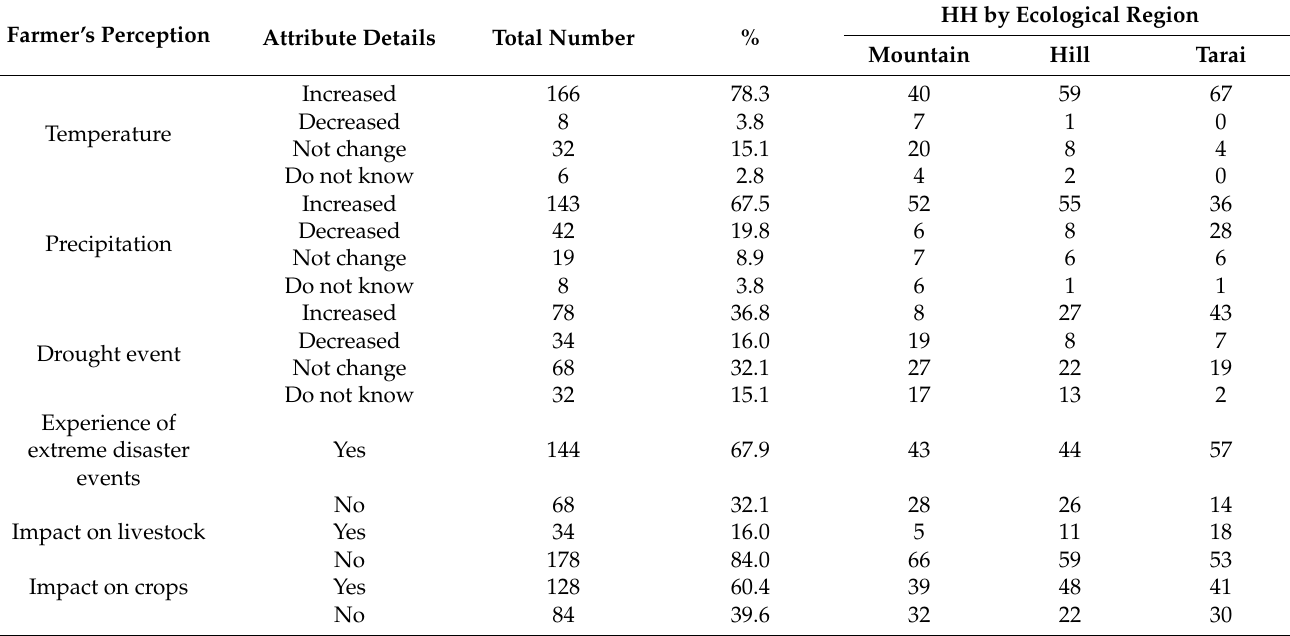
Table 5. Farmer’s perception and understanding of climate